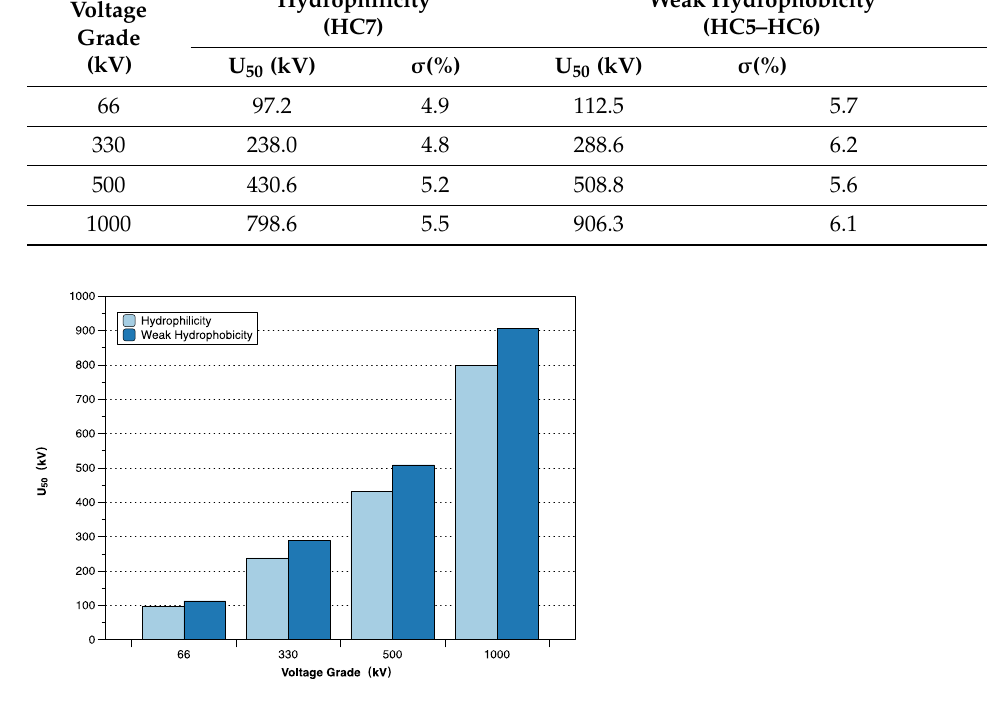
Table 3. Pollution flashover test results of composite crossarm insulators under hydrophilicity and weak hydrophobicity states.